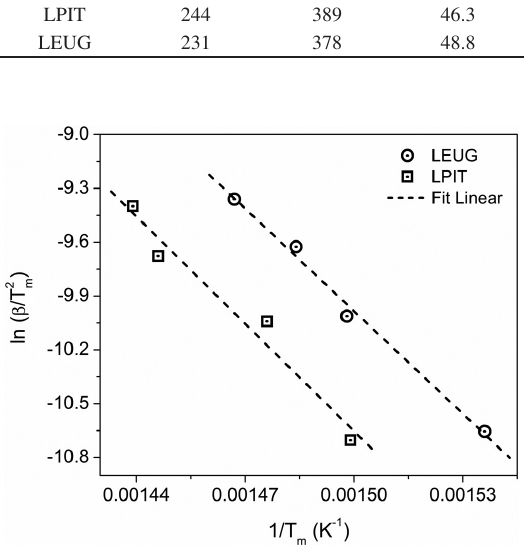
Figure 3. Plot of ln( b /T max2 ) against 1/T